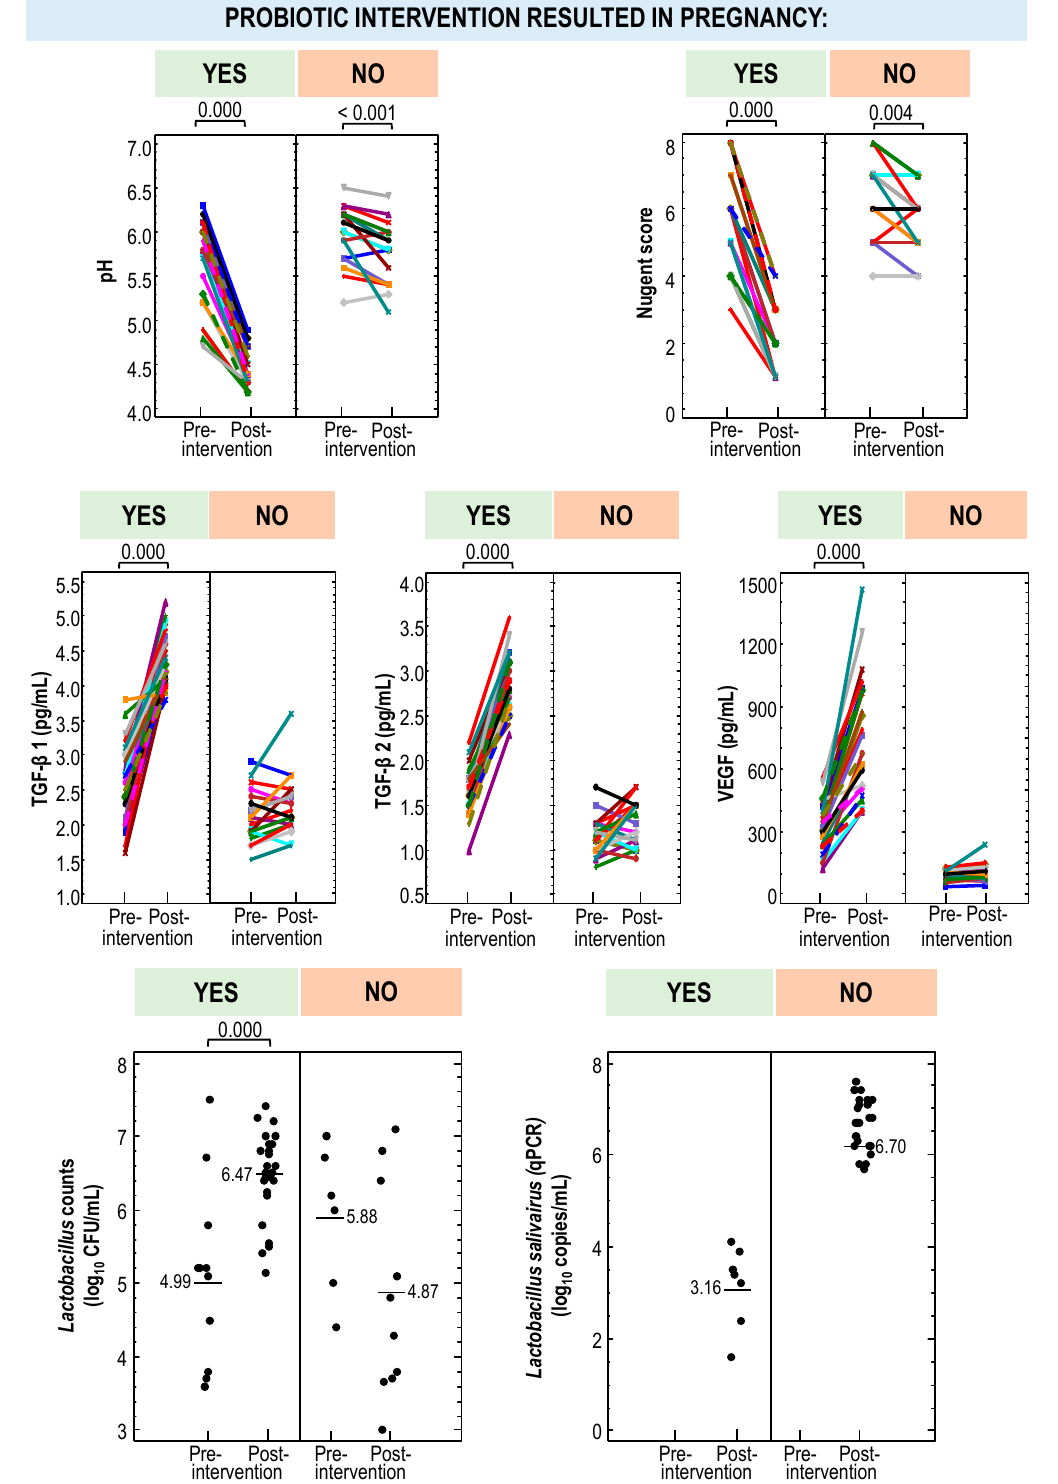
Figure 8. Changes in vaginal parameters (pH, Nugent score, TGF- β 1, TGF- β 2, and VEGF concentrations, viable Lactobacillus counts and L. salivarius copies in CVL samples) in women with a history of reproductive failure, because either of recurrent miscarriage (RA group) or infertility (INF groups), after the probiotic intervention with L. salivarius CECT5713 according to their outcome (pregnancy versus no pregnancy).